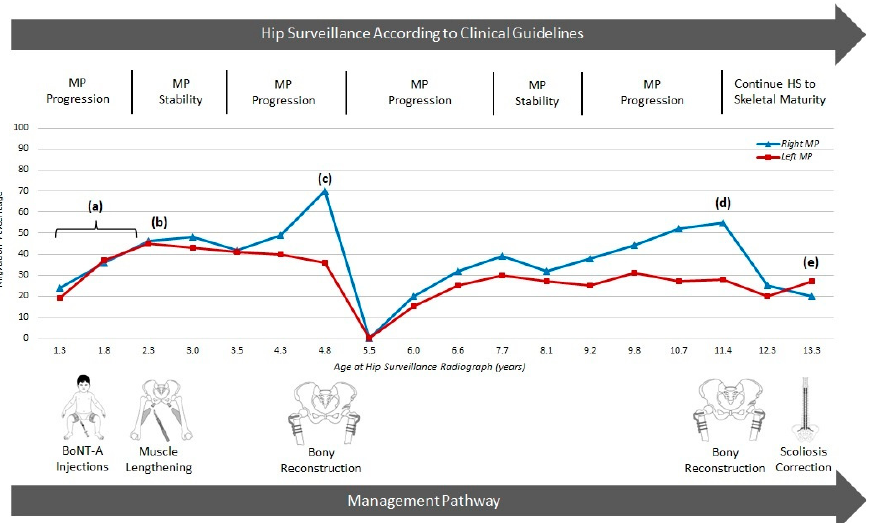
Figure 5. Hip surveillance and response to interventions for hip displacement for a child from age 1–13 years. Copyright Kate Willoughby, RCH Melbourne. The red line shows serial MP for the right hip; the blue line shows serial MP for the left hip, over time. This figure shows the interplay between the hip surveillance and management pathways of a girl who functioned at GMFCS IV and had regular HS and multiple interventions over a 13-year